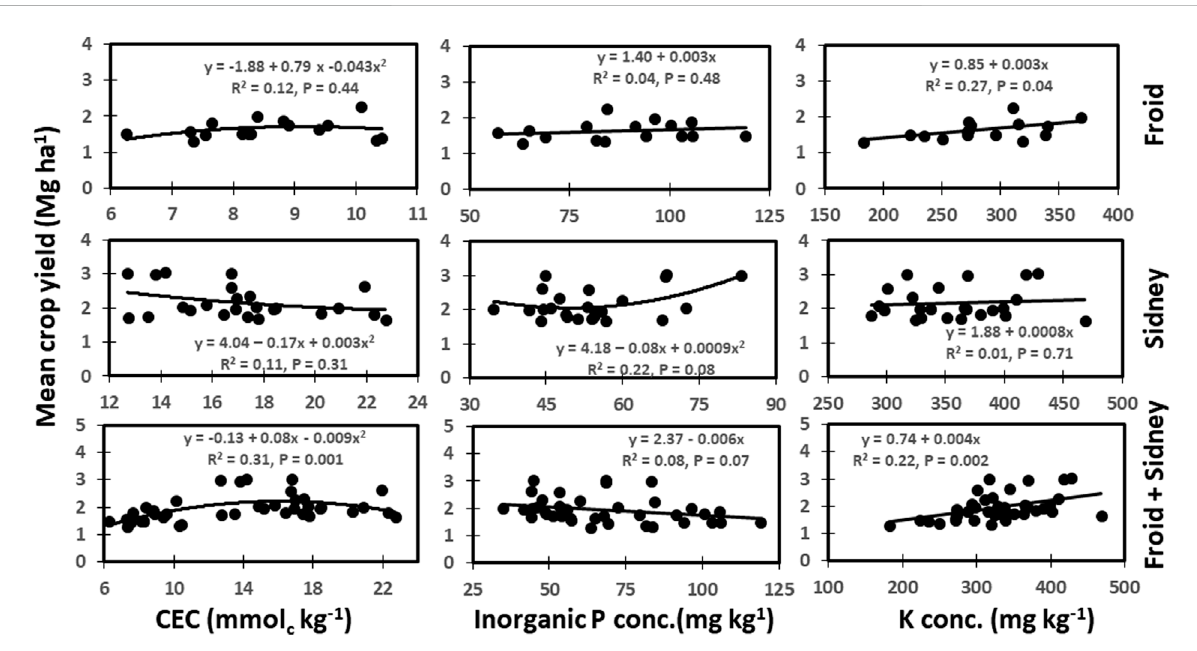
FIGURE 5 Relationships among cation exchange capacity (CEC), inorganic P (IP), and K concentration, and mean crop yield across years at Froid, Sidney, and the combined data from Froid and Sidney, Montana, United